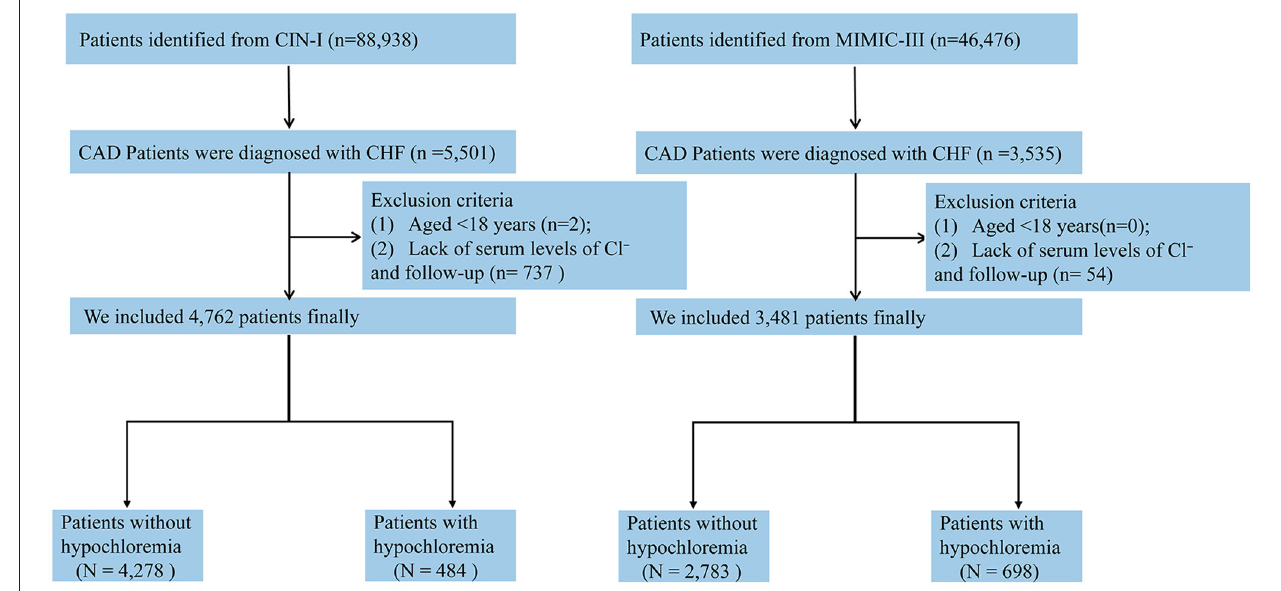
FIGURE 1 | The flow of participants through the